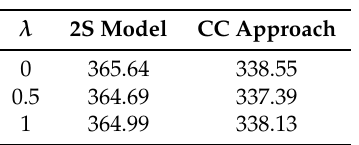
Table 4. Cost comparison ([k e ]) between decision approaches in out-of-sample tests ( α =